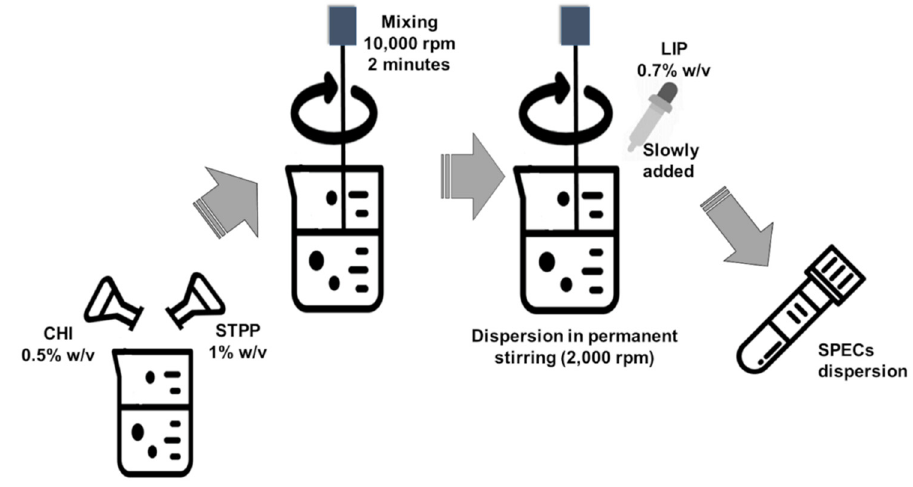
Figure 1. Schematic production of SPECs.